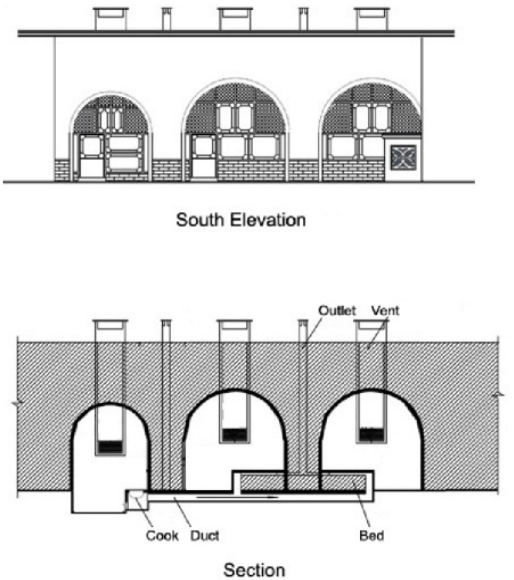
Figure 12. Cave-dwelling elevation and section.